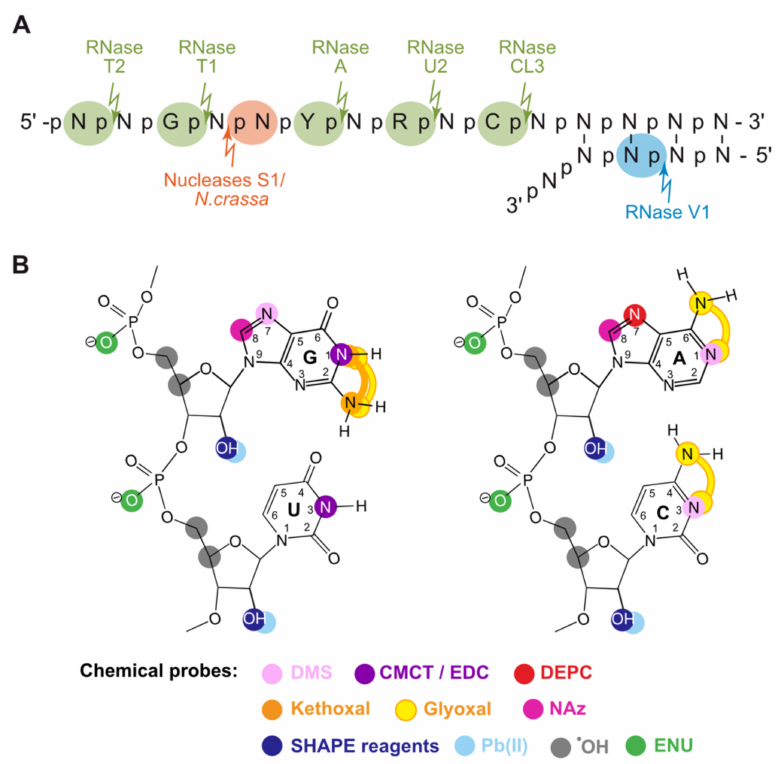
Figure 1. Enzymatic and chemical probes available nowadays. ( A ) Common enzymatic probes and their targets on ss- and dsRNA. The arrows and the highlighted nucleotides indicate whether the fragment formed after strand scission is 3 (cid:48) or 5 (cid:48) phosphate. ( B ) Main chemical probes and their target positions on base, sugar, and phosphate. DMS: dimethylsulfate; CMCT: 1-cyclohexyl-3-(2-morpholinoethyl) carbodiimide metho-p-toluenesulfonate; EDC: 1-ethyl-3-(3- dimethylaminopropyl)carbodiimide; DEPC: diethylpyrocarbonate; kethoxal: 3-ethoxy-1,1-dihydroxy- 2-butanone; SHAPE reagents are NMIA: N-methylisatoic anhydride, BzCN: benzoylcyanide, and NAI: 2-methyl nicotinic acid imidazolide; FAI: 2-methyl-3-furoic acid imidazolide; 1M6: 1-methyl- 6-nitroisatoic anhydride; 1M7: 1-methyl-7-nitroisatoic anhydride and 2A3: 2-aminopyridine-3- carboxylic acid imidazolide; NAz: nicotinoyl-azide; Glyoxal: ethanedial [40]; ENU: ethyl-nitrosourea; Pb(II): lead ion; • OH: hydroxyl